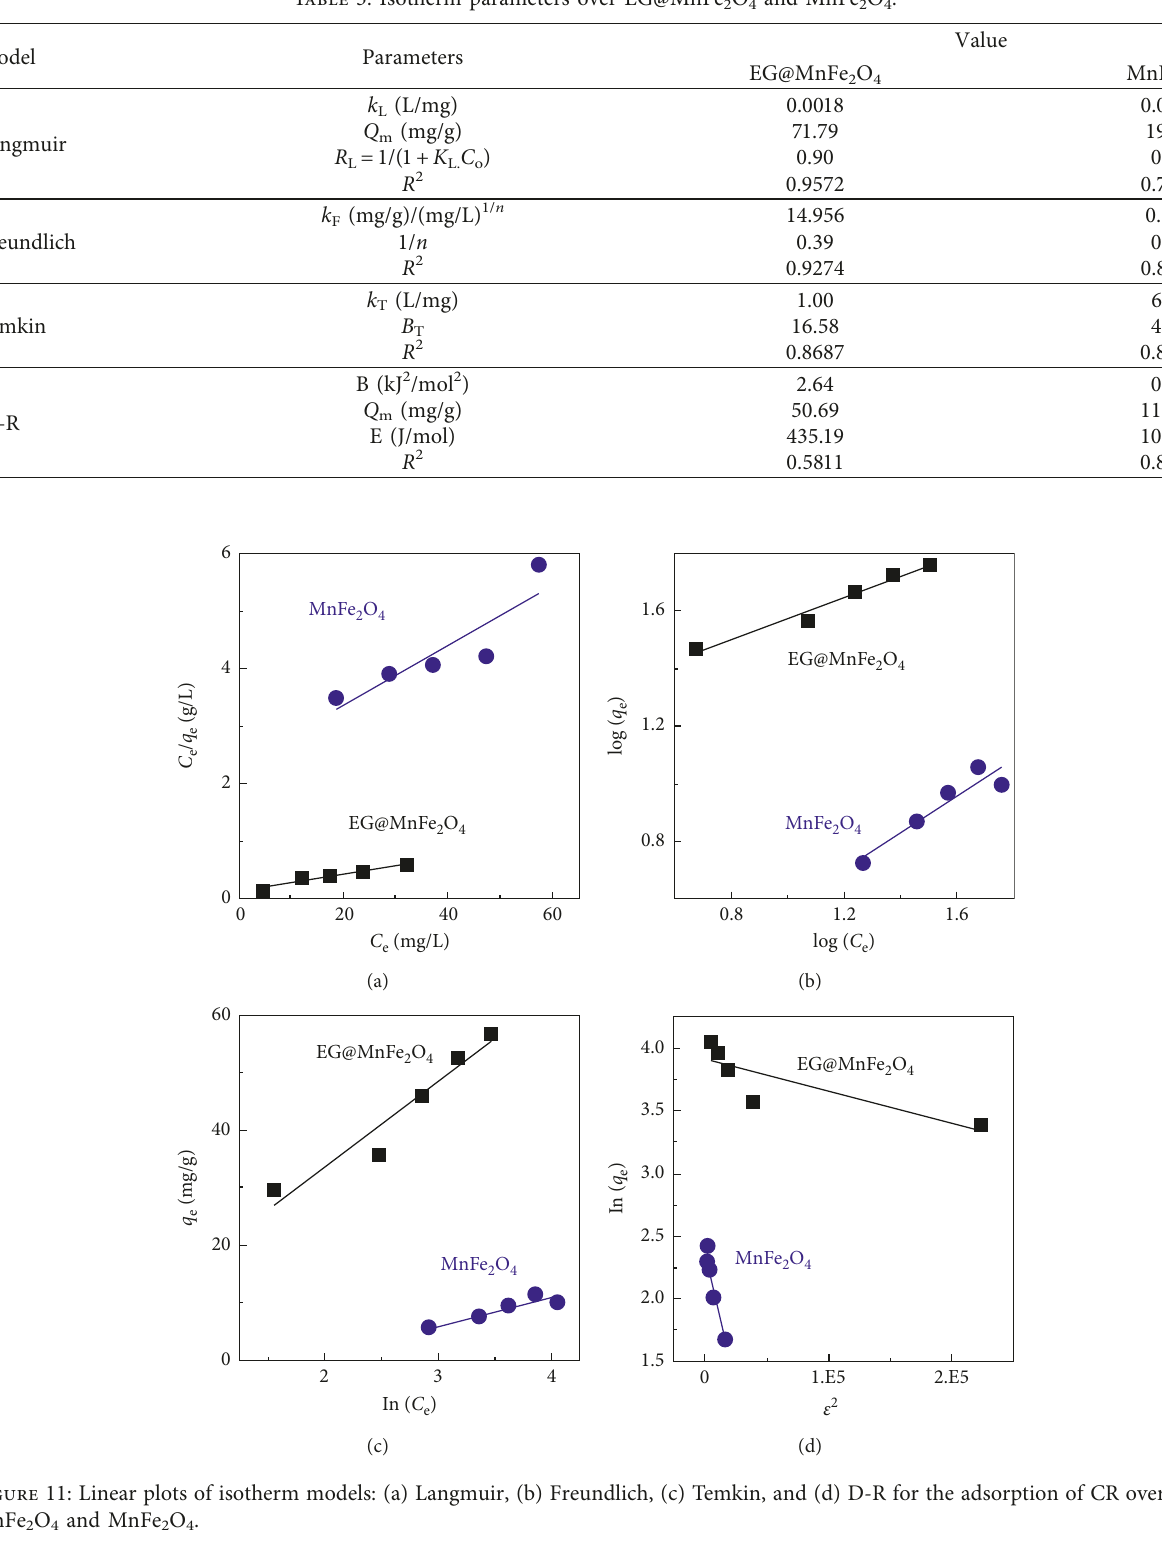
Table 3: Isotherm parameters over EG@MnFe